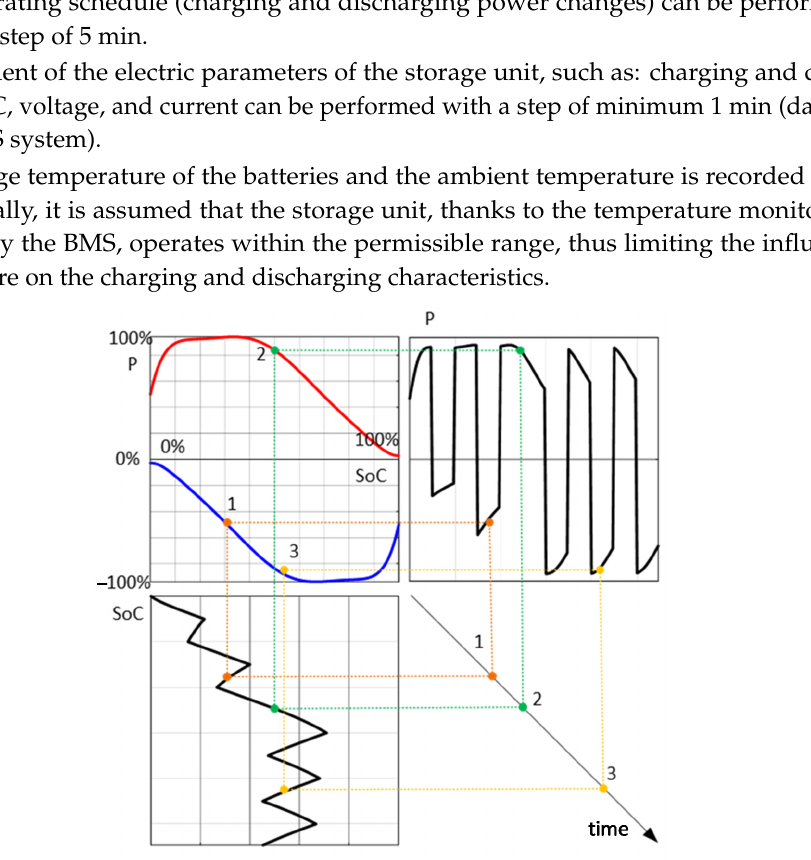
Figure 5. The result of the approximation of the results with the 1 min data polynomial function. The final characteristics determined on the basis of 1 min data are as in Figure 6.